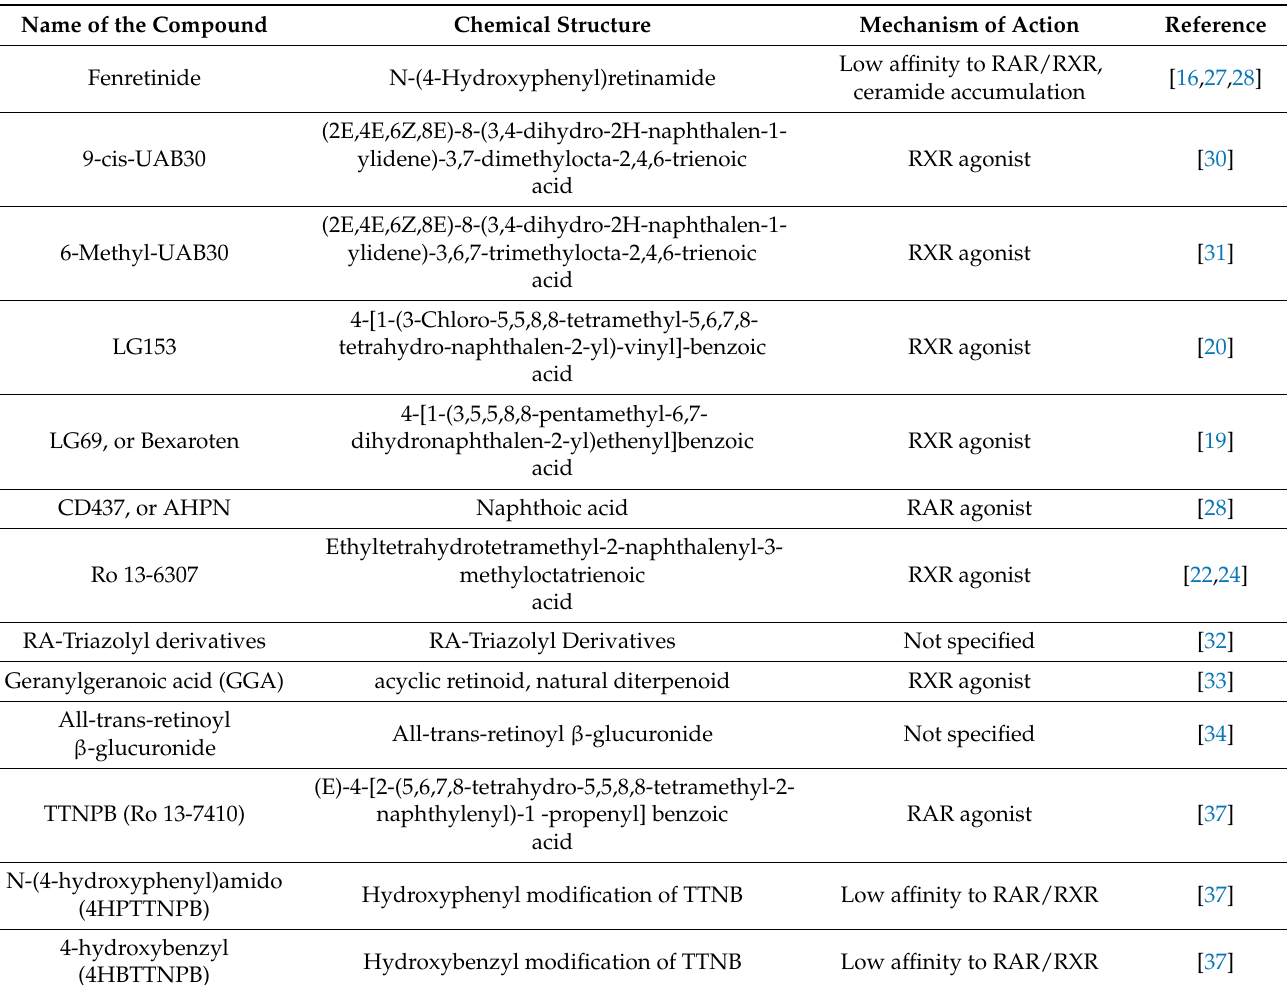
Table 1. Chemical structures and mechanisms of action of RA metabolites and derivatives tested using neuroblastoma (NB) cell